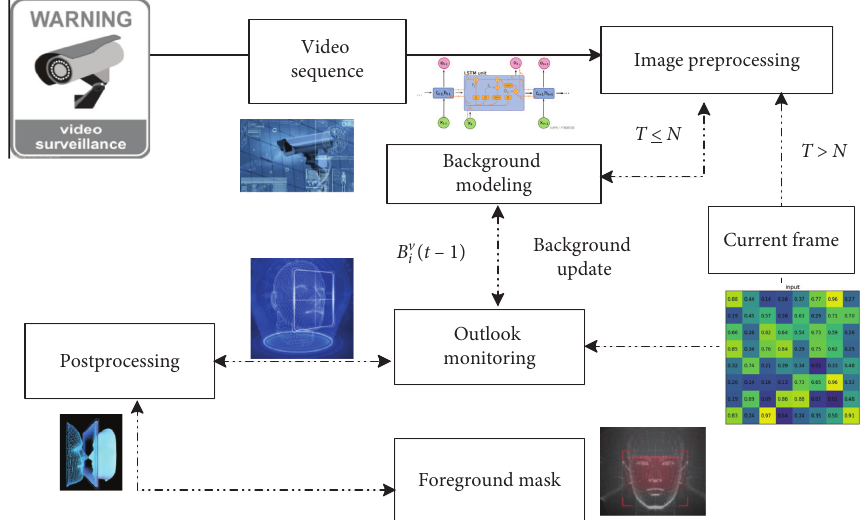
Figure 1: The structure of the scene difference